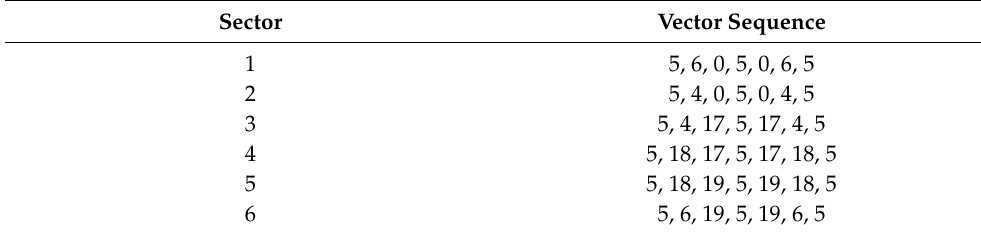
Table A6. Vector switching sequences of the fifth outer hexagon, by the ith designation (V i ).